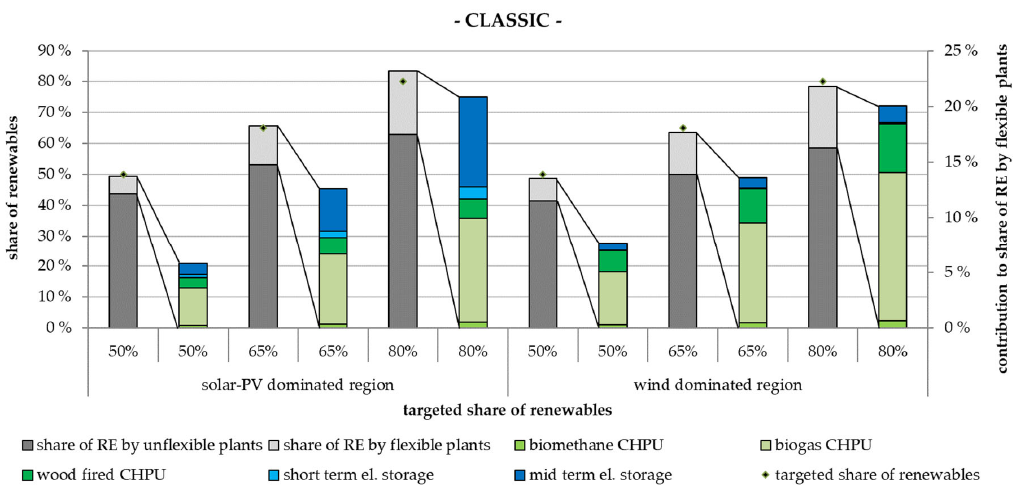
Figure 3: Achieved share of renewables in the electricity consumption of the model regions. Figure 3. Achieved share of renewables in the electricity consumption of the model